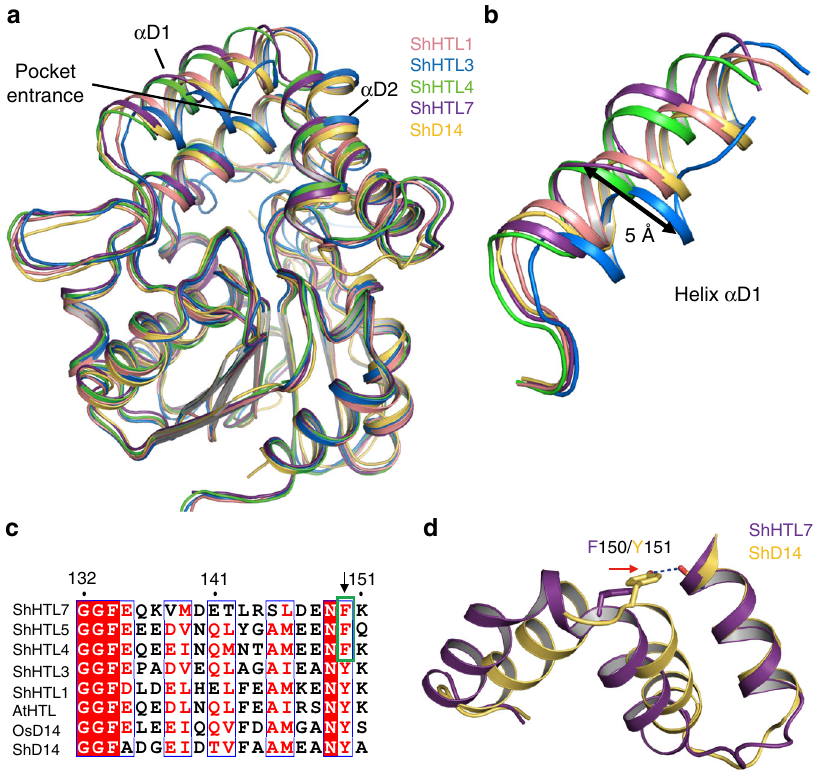
Fig. 3 Structural comparison of ShHTLs and ShD14. a Structural overlay of ShHTL1, ShHTL3 (PDB code: 5DNW [https://doi.org/10.2210/pdb5DNW/ pdb]), ShHTL4, ShHTL7, and ShD14 are colored in pink, blue, green, deep purple, and yellow, respectively. b A detailed view of helix α D1 is shown. The maximum difference between ShHTL3 and ShHTL7 (approx. 5 Å) is shown by an arrow. c Sequence alignment of residues 132 − 151 of HTLs and D14s. The green box shows the F150 of ShHTLs in the highly sensitive subgroup (ShHTL4, ShHTL5, and ShHTL7). d Structural alignment of ShHTL7 (deep purple) and ShD14 (yellow) with the hydrogen bond between Y151 ShD14 and L178 (main chain carbonyl oxygen atom) is shown as a dashed